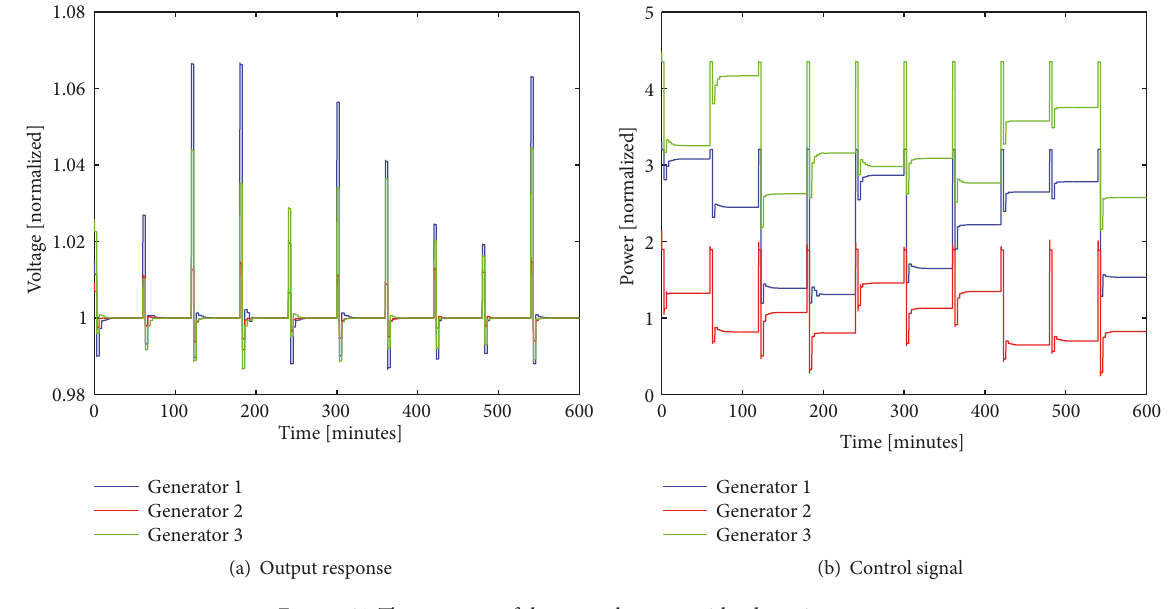
Figure 21: The response of the control system with adaptation process.